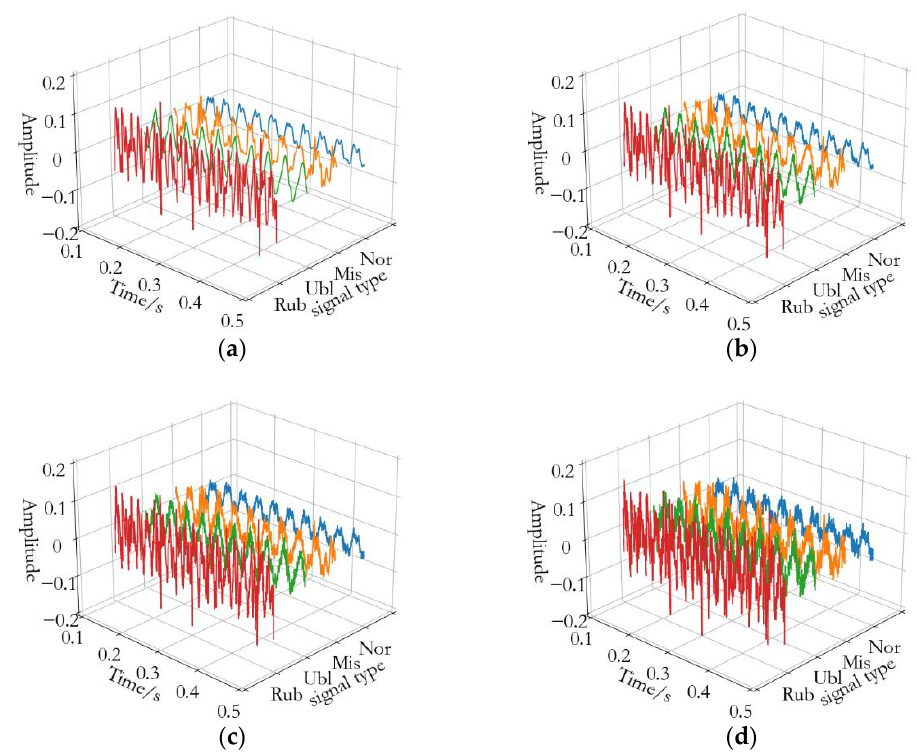
Figure 5. Vibration signals with different signal-to-noise ratios: ( a ) original signal; ( b ) SNR = 15 dB; ( c ) SNR = 10 dB; ( d ) SNR = 5 dB.